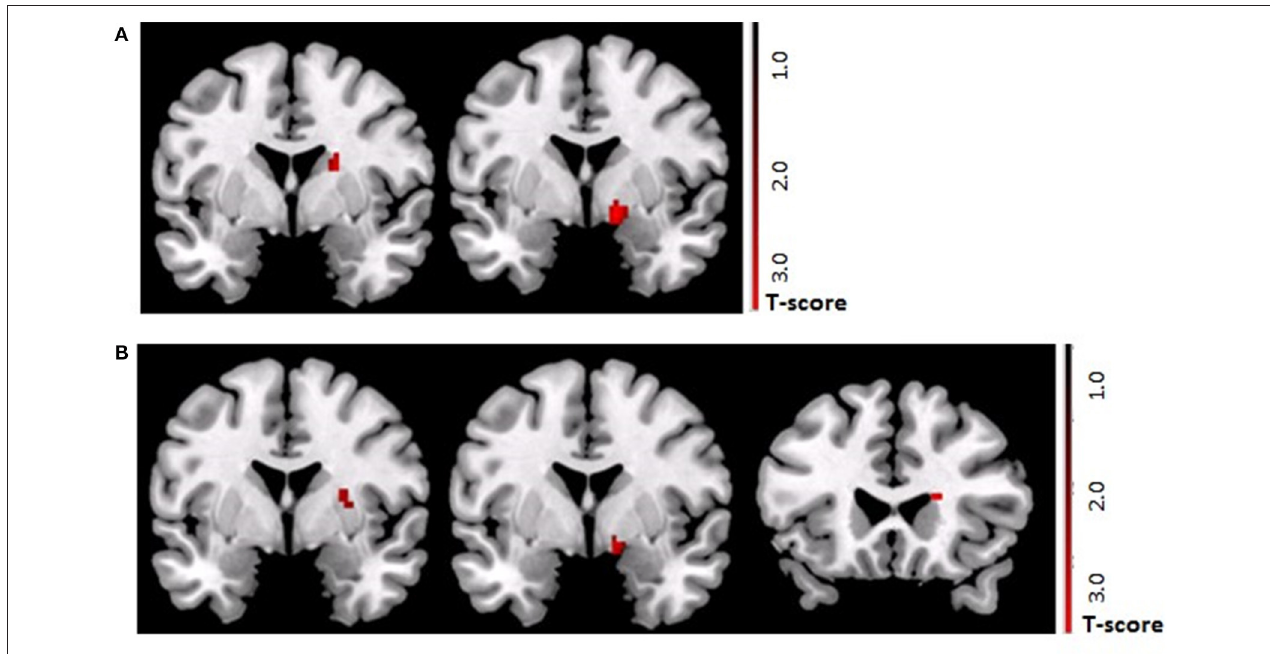
FIGURE 5 | (A) ROI based analysis of brain activation ( p FWE < 0.05) in the TGA group. Contrast SECPT > control procedure during acquisition phase (CON + > CON − ) of the contextual fear conditioning paradigm showing a stronger activation of the right ventral striatum ( x = 19, y = 3, z = − 5; T = 3.83) after the SECPT. (B) ROI based analysis of brain activation ( p FWE < 0.05) following the SECPT. Contrast TGA > control group during the acquisition phase (CON + > CON − ) of the contextual fear conditioning paradigm showing a stronger activation of the right ventral striatum ( x = 19, y = 17, z = − 11; T = 3.53) in the TGA group. ROI, region of interest; CON + , conditioned stimulus paired with the unconditioned stimulus; CON − , conditioned stimulus never paired with the unconditioned stimulus; SECPT, Socially Evaluated Cold Pressor Test; TGA, transient global amnesia.